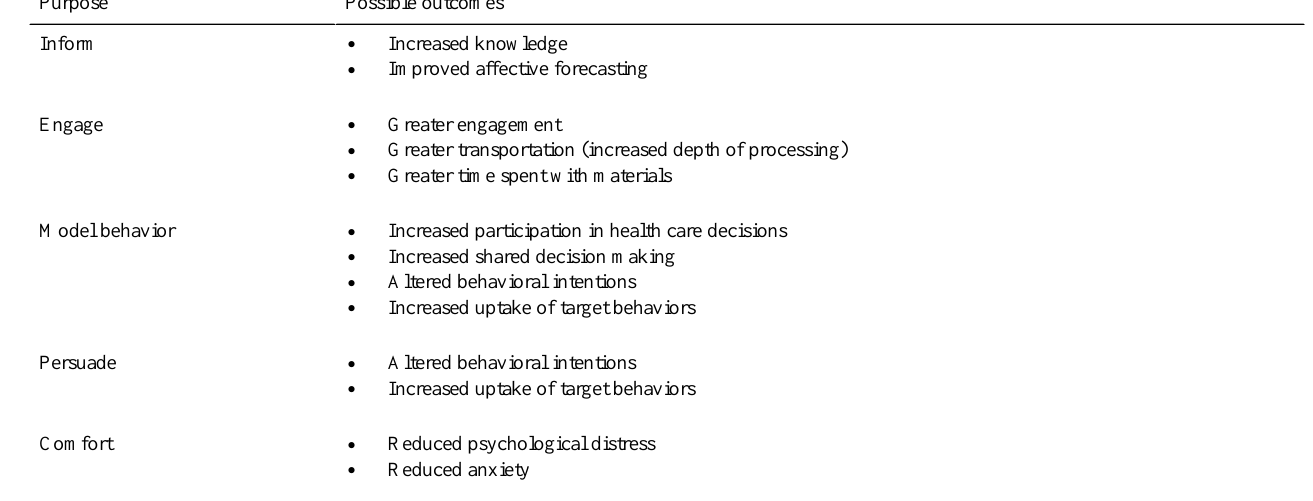
Table 1. Purposes of